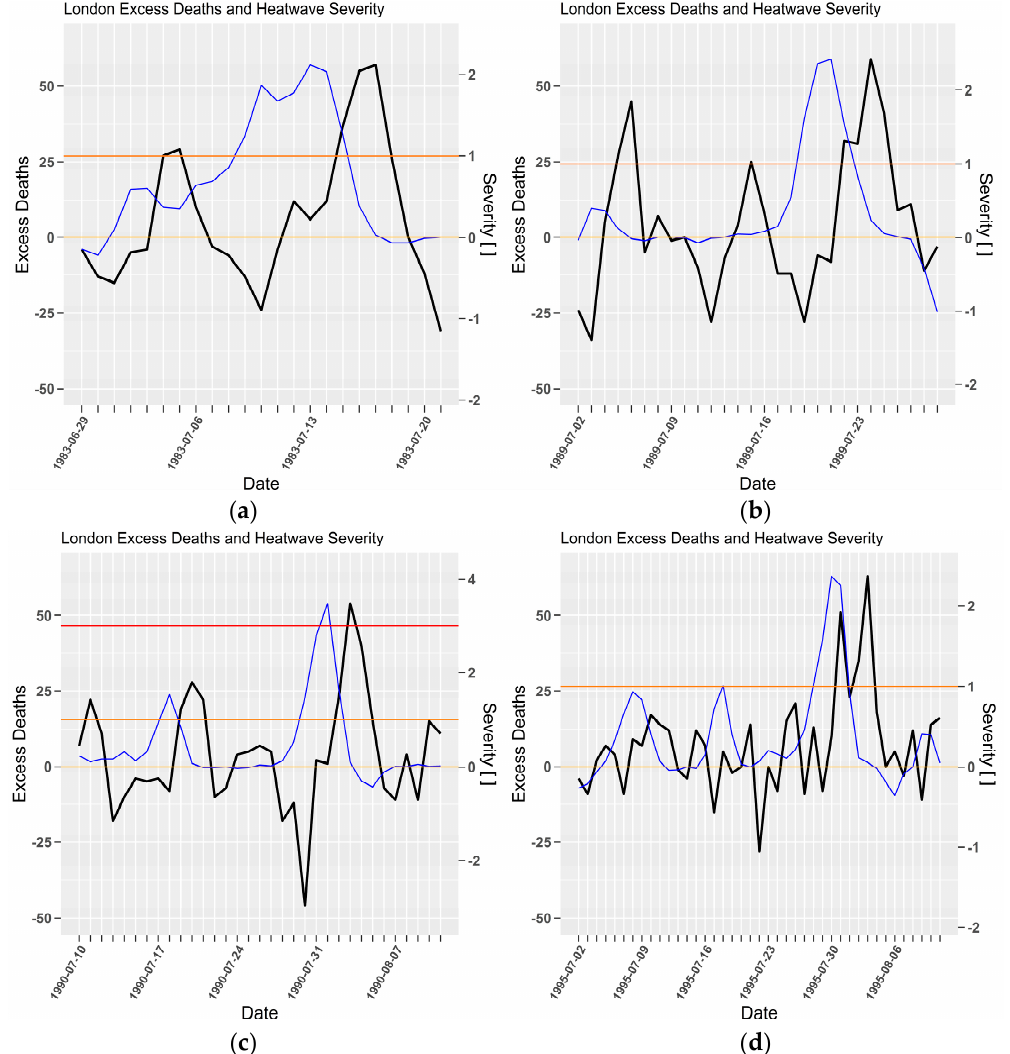
Figure 4. As per Figure 3. London (Heathrow) severity (blue) and mortality (black) for 1983 ( a ), 1989 ( b ), 1990 ( c ) and 1995 ( d ) heatwaves. Daily excess deaths and severity (dimensionless) on left and right y -axes, respectively.